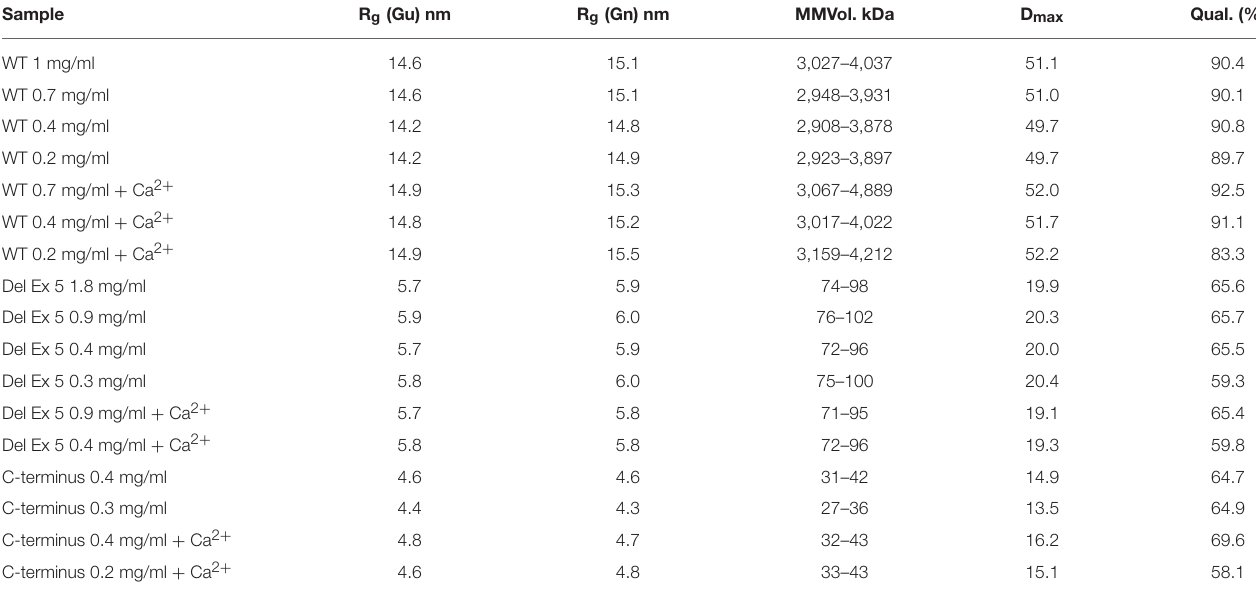
TABLE 2 | Results from small angle X-ray scattering (SAXS) of AMBN, DelEx5 and C-terminus.